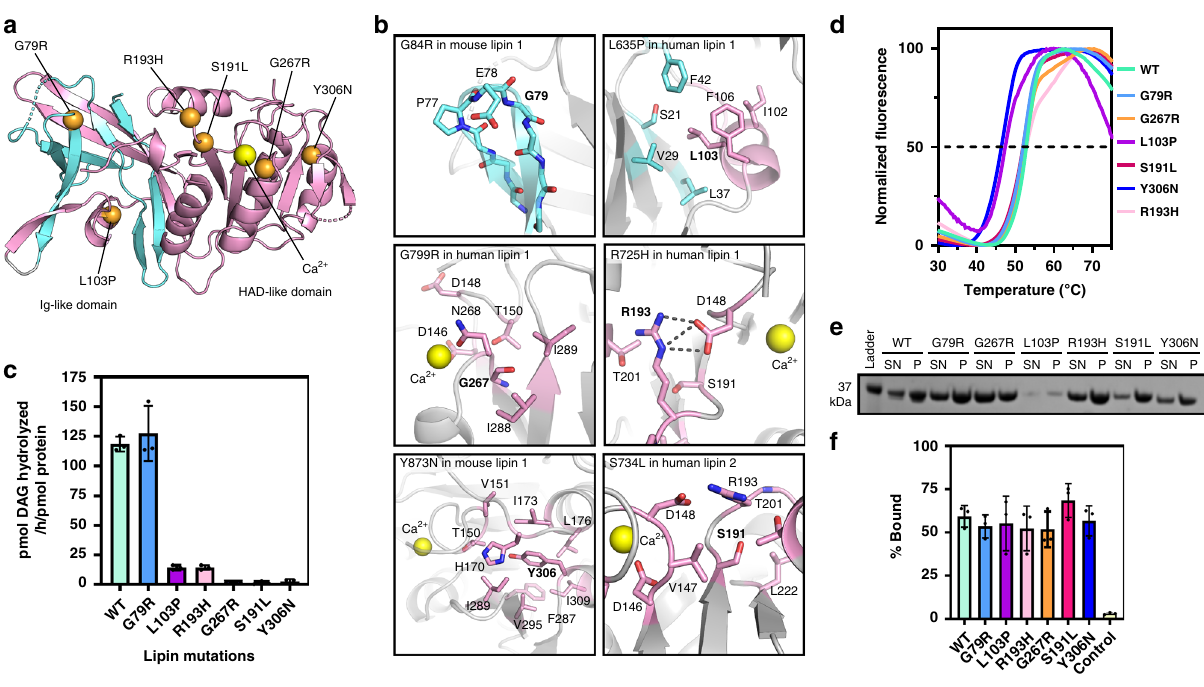
Fig. 5 Structural mapping of disease mutations. a Mapping of disease-associated mutations (orange spheres) in human and mouse lipins on the Tt Pah2 structure. A yellow sphere indicates the calcium ion. b Detailed view of the structural interactions of native residues in Tt Pah2 that are mutated in lipin-related pathologies. c Affects of disease mutations on the PAP activity of Tt Pah2. Error bars represent standard deviation ( n = 3) of experiments performed in technical duplicates. d Effects of disease mutations on the thermal stability of Tt Pah2 protein assessed by differential scanning fl uorimetry. Data are representative of two independent experiments. e SDS-PAGE analysis of liposome sedimentation assay with wild-type Tt Pah2 and disease- associated mutants. f Quanti fi cation of liposome association for wild-type Tt Pah2 and disease mutants expressed as % bound. Data are the means and SDs of three experiments. Source data are provided as a Source Data fi